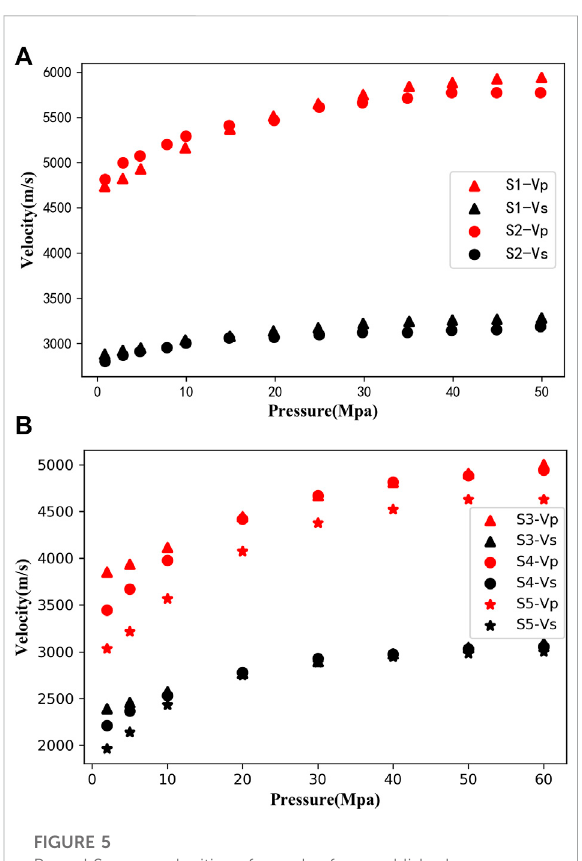
FIGURE 6 Comparison of S-wave velocity measured in laboratory with predicted value of DNN. (A) Prediction results. (B) Relative